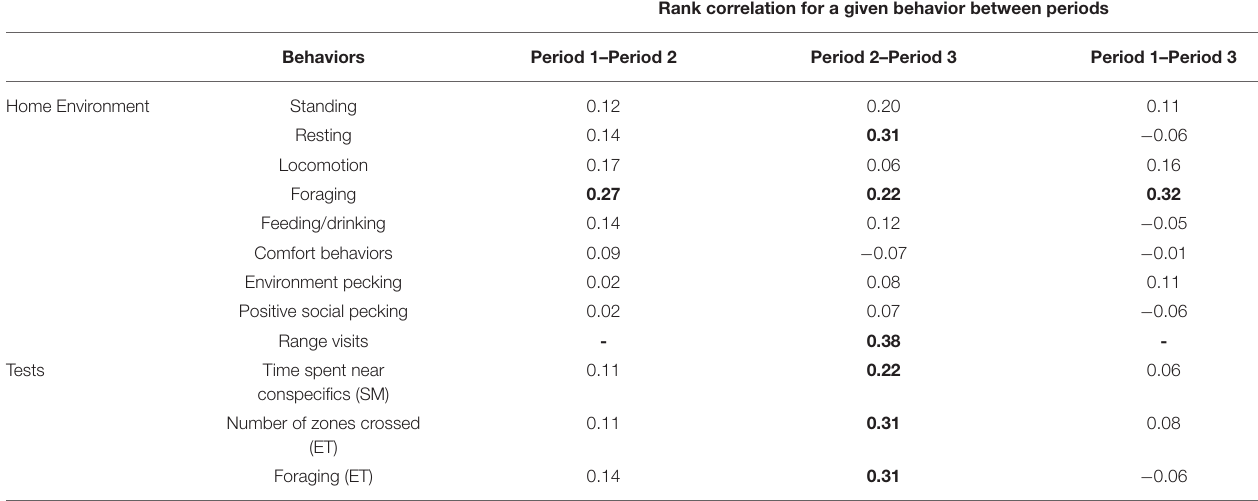
TABLE 4 | Consistency (rank correlations) of different behaviors of male free-range broiler chickens over different